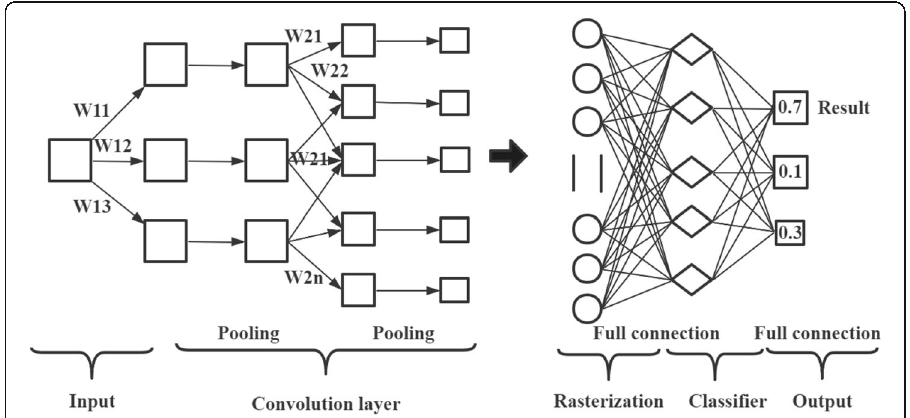
Fig. 1 convolution neural network processing